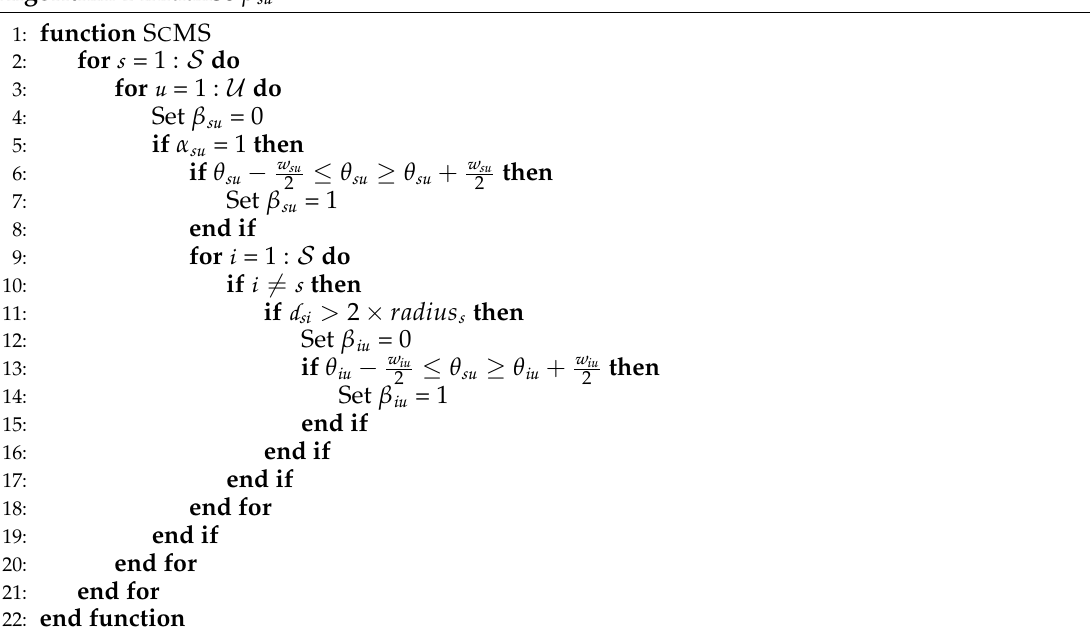
Algorithm 1 Initialise β